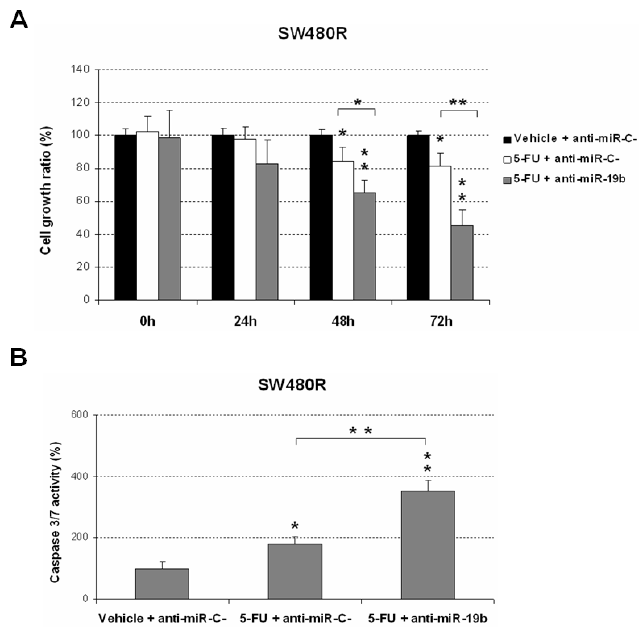
Figure 2. Role of miR-19b in resistance to 5-FU treatment. ( A ) MTS assay and ( B ) caspase 3/7 assay showing effects of miR-19b downregulation in SW480R cells treated with 5-FU (1 µ M); * p < 0.05; ** p < 0.01. Asterisks over the columns refer to the comparison of each condition against the control (first column).